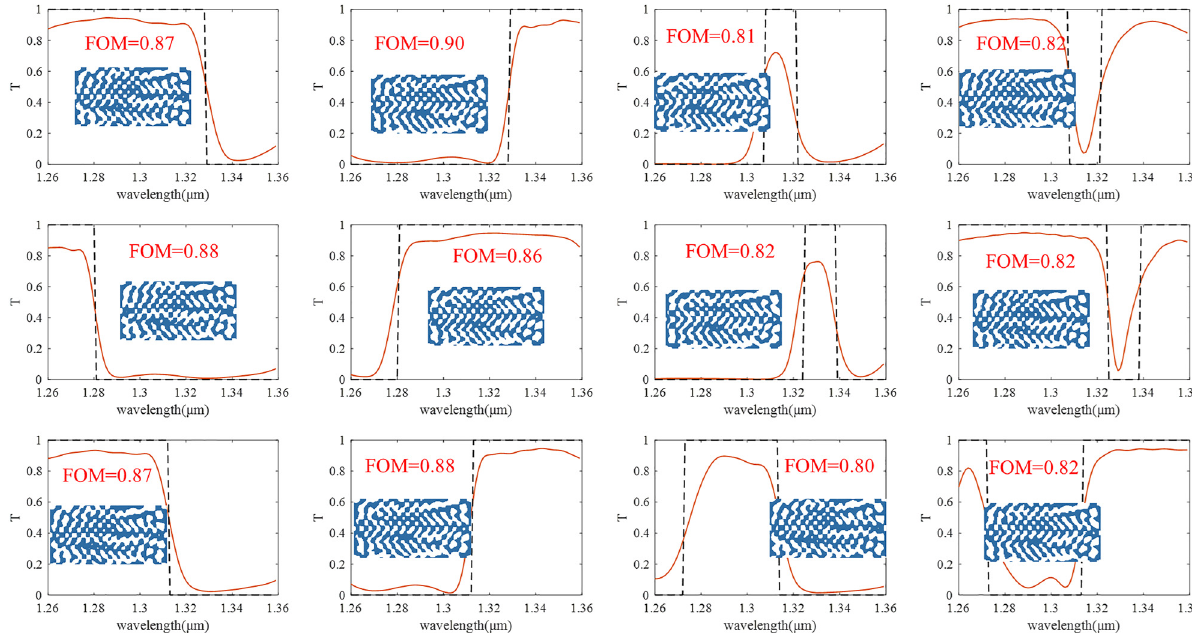
Figure 6: Illustration of 12 predicted wavelength filters. The dashed lines represent the randomly generated optical targets, while the solid lines represent the actual optical responses of predicted devices by the trained DNN. The insect images of each subplot figure show the predicted device structures.